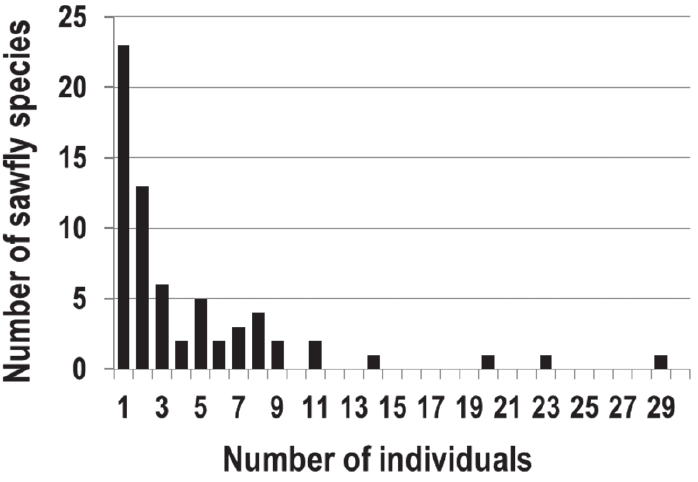
Figure 4. Number of species versus number of individuals captured in the DMWP sample. In addi- tion, one species had 58, one had 84, and one had 251 individuals which are not shown on this graph to conserve